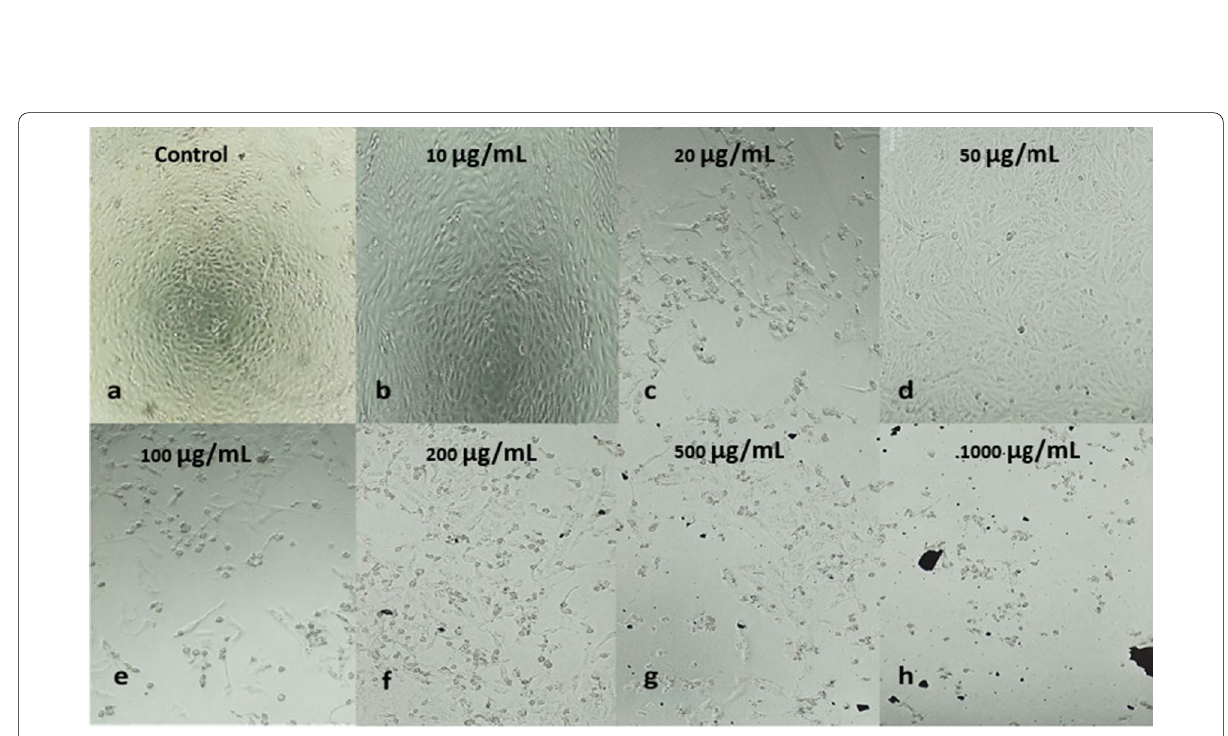
Fig. 8 HEPG2 cell lines after 72 h incubation with various concentrations of Au@AgNPs compared with the control (without